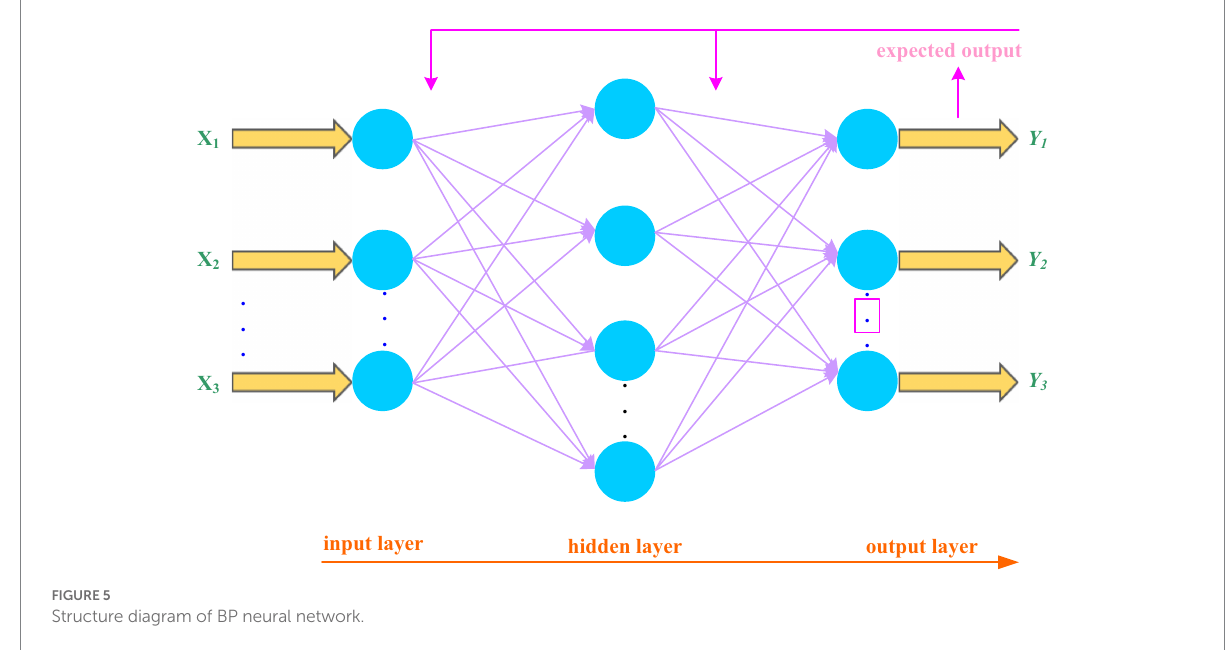
FIGURE 5 Structure diagram of BP neural